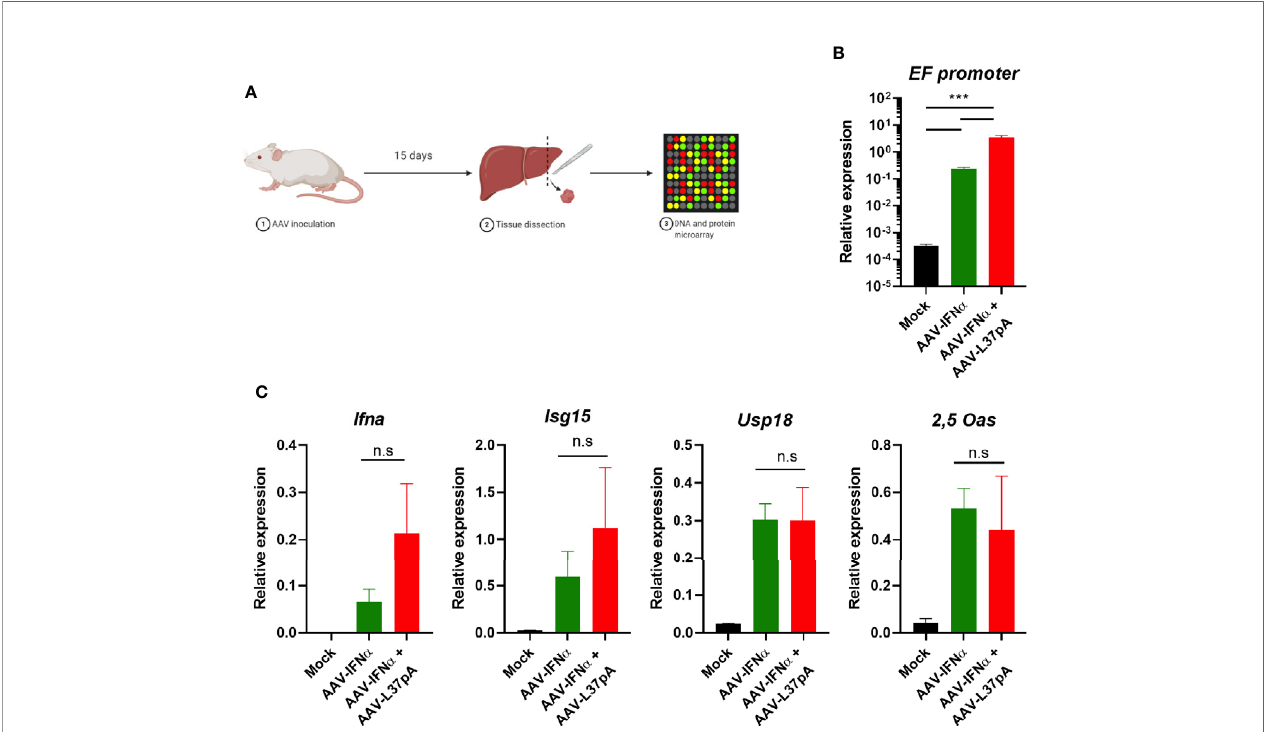
FIGURE 2 | Comparable AAV infection and expression IFN related genes in the liver two weeks after AAV administration. C57BL/6 mice (N = 3) were left untreated (Mock) or received 1.2x10 11 vg/mouse of AAV-IFN a alone (AAV-IFN a ) or combined with 9.5x10 11 vg/mouse AAV-L37pA. Two weeks later, mice were sacri fi ced and DNA, RNA and proteins from livers were puri fi ed. (A) Schematic representation of the experimental setting. (B) AAV viral genome was quanti fi ed by quantitative PCR of total DNA. (C) The expression of the AAV transgene mIFN a and the interferon-stimulated genes, interferon-stimulated gene 15 (ISG15), ubiquitin-speci fi c peptidase 18 (USP18), and 2 ’ -5 ’ -oligoadenylate synthetase (2,5-OAS) were determined by RT-qPCR. Mean ± SEM is represented. n.s, non-signi fi cant; ***p < 0.001 One-way ANOVA followed by Tukey ’ s multiple comparisons